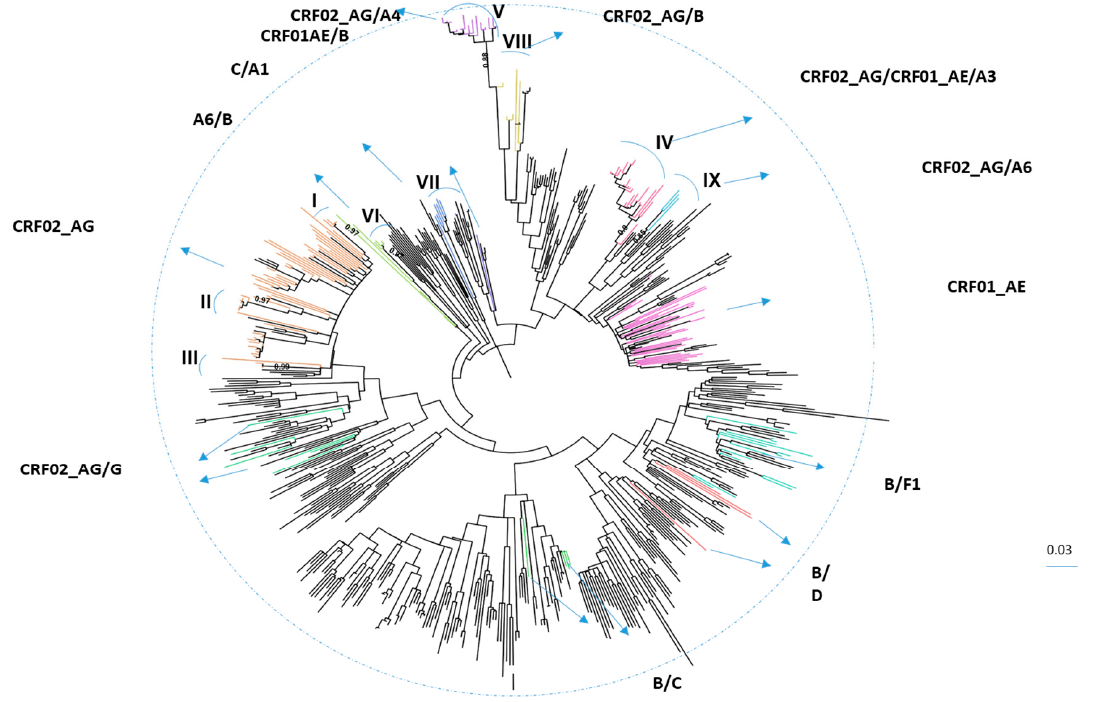
Figure 2. Phylogenetic analysis of HIV-1 recombinants in Israel, 2010–2018. Phylogenetic tree of the pol region of HIV-1 from 213 patients was generated by the Mega X and constructed using the maximum likelihood (ML) with GTR + G + I model. Included were also 410 reference sequences (pure and recombinant forms) obtained from the Los Alamos database. The tree was visualized in Fig Tree version 1.4.4. HIV-1 recombinants are colored as follows: CRF02_AG in pink, CRF01_AE in purple, CRF01_AE/B in violet, CRF02_AG/CRF01_AE/A3 in rose, B/F1 in turquoise, CRF02_AG/A4 in lilac purple, A6/B in green, C/A1 in blue, CRF02_AG/B in gold, CRF02_AG/A6 in magic mint, CRF02_AG/G in Caribbean green, B/C in green, and B/D in terrain. Reference sequences are in black. The main clusters were determined according to the bootstrap values (>0.8) and number of individuals (>2) in each cluster and named with the Roman letters (I–IX) and indicated with the blue splines. The bootstraps of each cluster were: I. 0.97; II. 0.97; III. 0.99; IV. 0.9; V. 0.88; VI. 0.97; VII. 1; VIII. 1; IX.